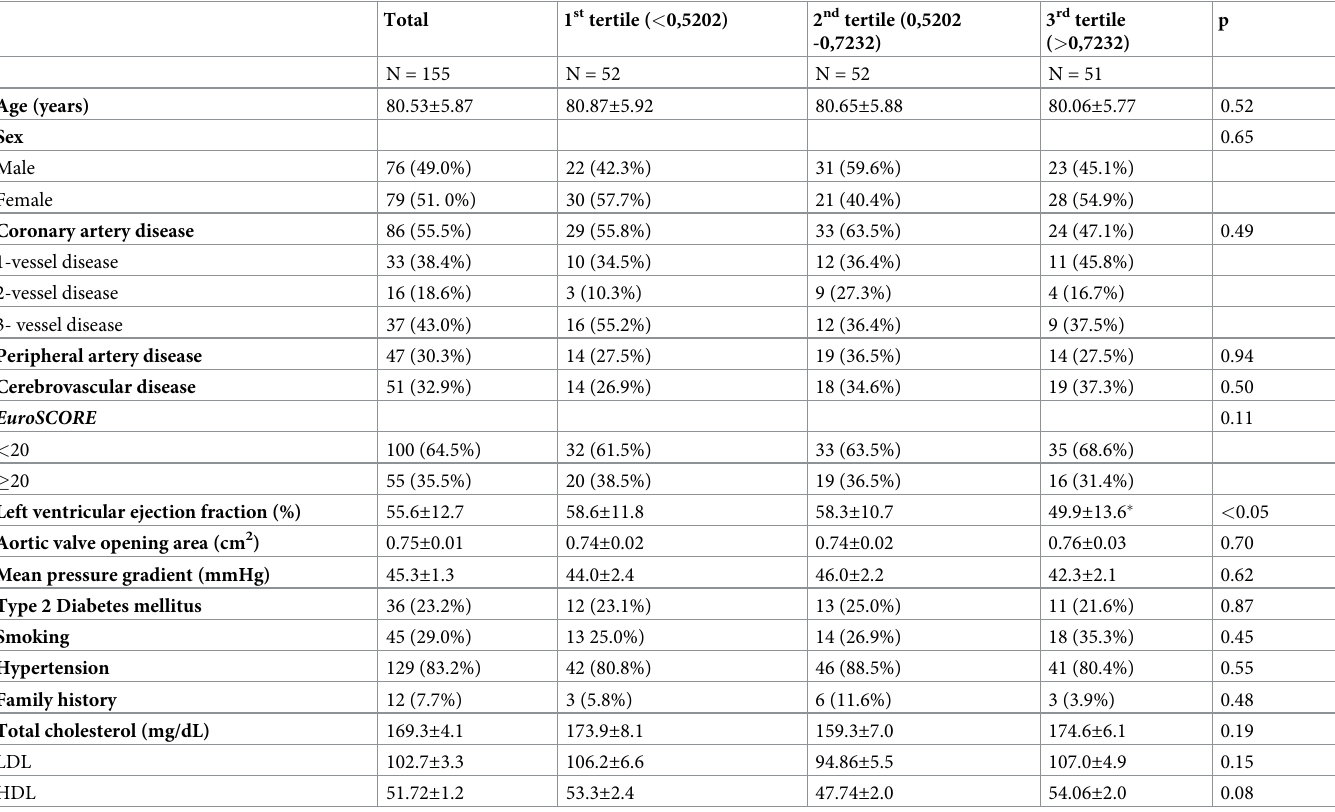
Table 1. Baseline characteristics. Cardiovascular disease, risk profile and echocardiographic parameters are displayed for all patients (total) and split in tertiles referring to telomere